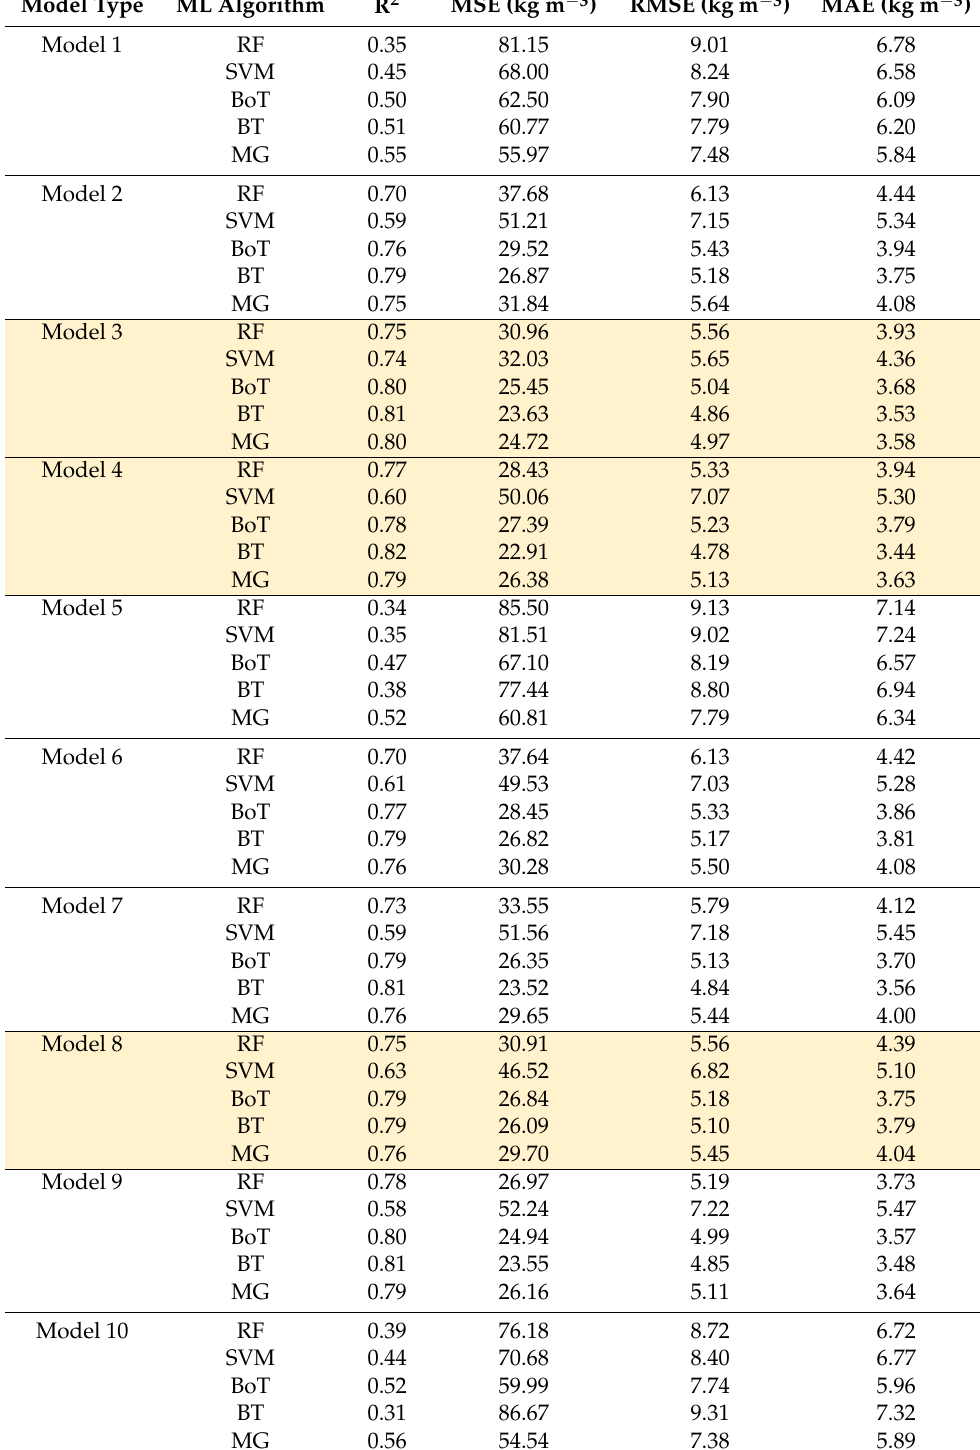
Table 3. Model evaluation during the testing phase for maize crop water productivity (CWP) using coefficient of determination (R2), mean square error (MSE), root mean square error (RMSE), and mean absolute error (MAE) for an ensemble of five machine learning algorithms viz., random forest (RF), support vector regression (SVM), bagged trees (BT), boosted trees (BoT), and matern 5/2 Gaussian process